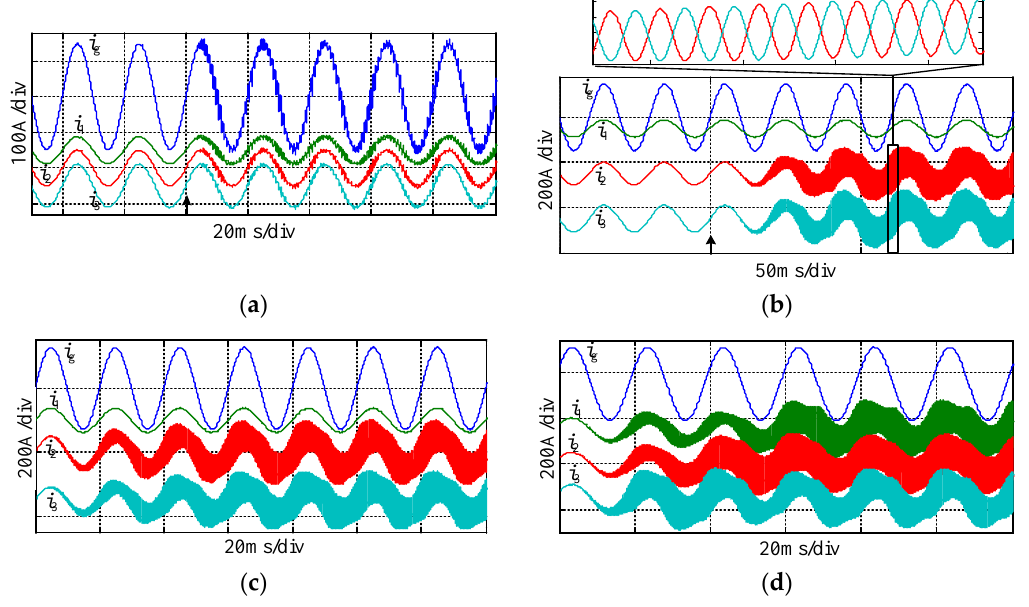
Figure 10. Simulation results: ( a ) System I switches to state-B from state-A; ( b ) System I switches to state-C from state-A; ( c ) System II works in state-D; ( d ) System III works in state-E.